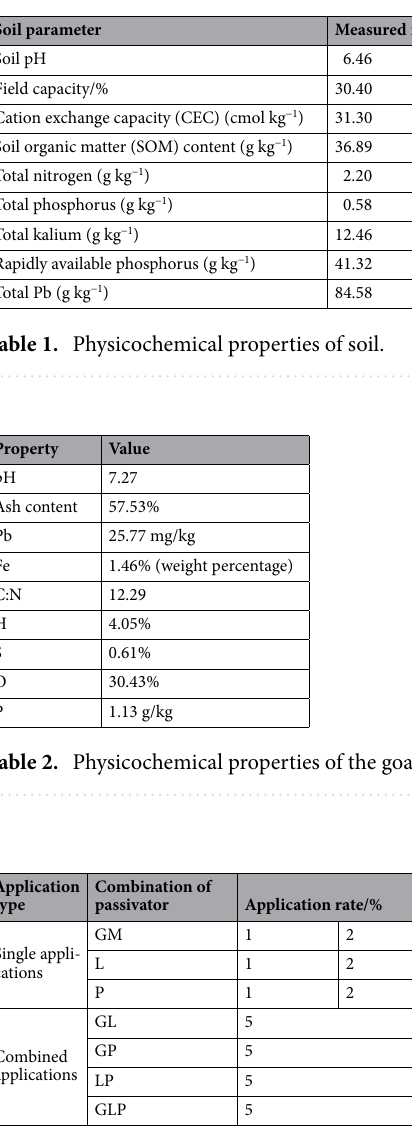
Table 3. Treatment category and application ratio. Combined applications: mixing GM, L, and P by a ratio of